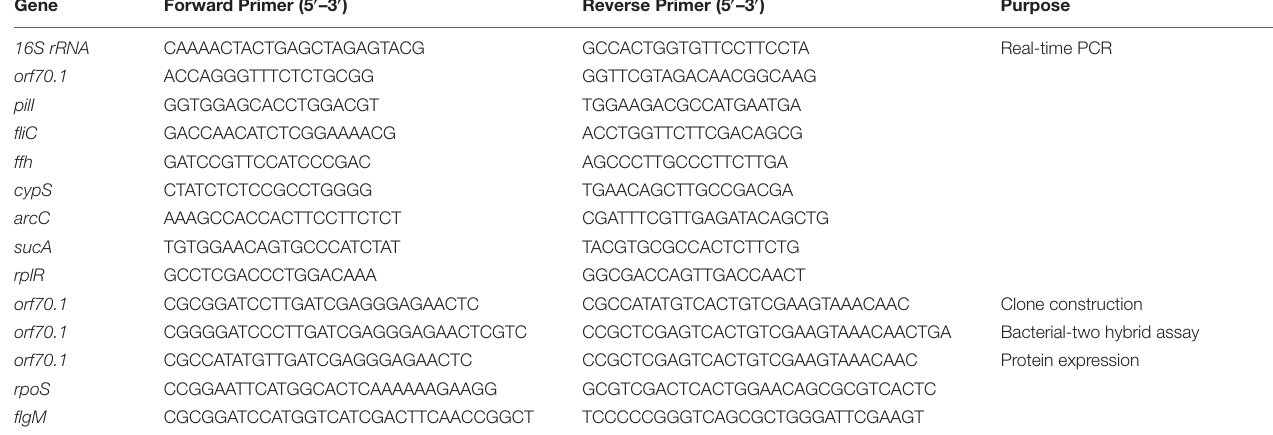
TABLE 2 | Primers used in this